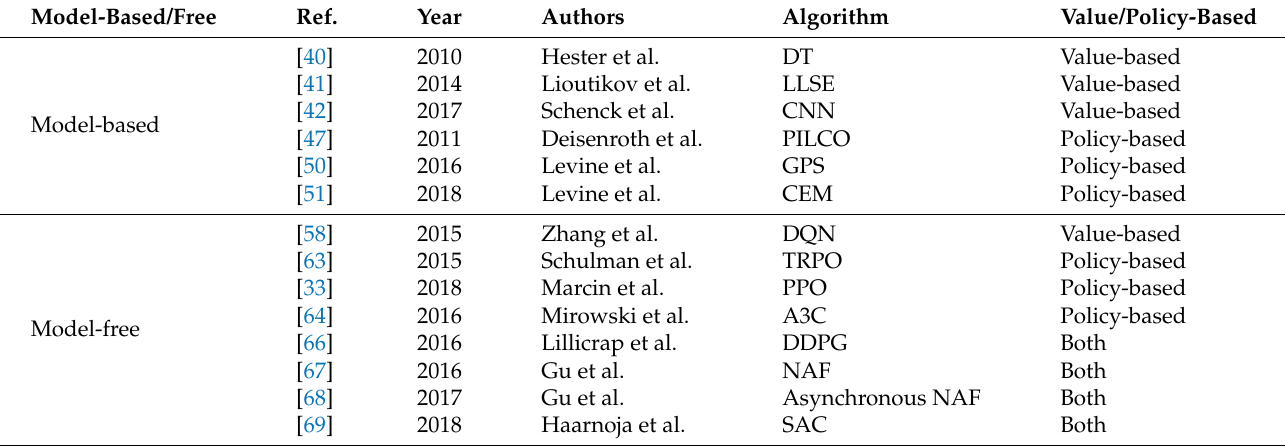
Table 1. Robot algorithms based on reinforcement